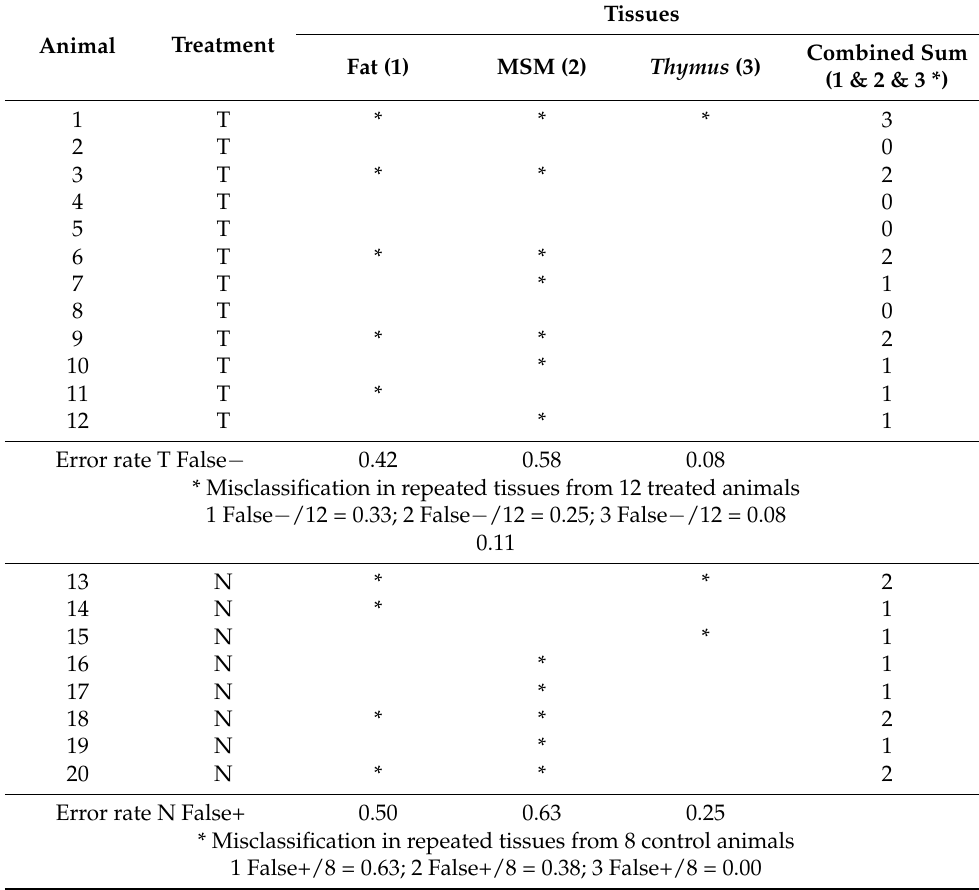
Table 3. List of the validated classifications, with misclassifications indicated with *, of the twelve treated animals (T false − ) and eight control animals (N false+) based on the three most accessible tissues in the “cut-off b” (740–1070 nm) spectrum subrange of the cut-off spectra, with the error rate of the combined